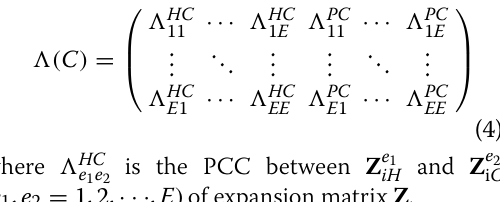
The coupled feature construction algorithm has the fol- lowing characteristics: (1) The algorithm is an unsuper- vised learning method with strong generalization ability; (2) The robustness of the algorithm can be improved using global data; (3) The size of the power can be set flexibly according to the actual situation to extract the coupling relations; (4) The coupled features have physi- cal interpretability and can be quantified to provide data support for subsequent interpretability research. Previous study has shown that the maximal expan- sion number E 3 or 4 is large enough to capture the = global couplings of attributes [13]. Thus, in the following experiments, the extended power E is taken as 3 to avoid excessive computation. A total of 9 coupled features are extracted, called CFR1-9. CFR1-3 mainly describe the coupling relations between cold load and other loads, while CFR4-6 and CFR7-9 describe the coupling rela- tions of heat load and electric load, respectively.